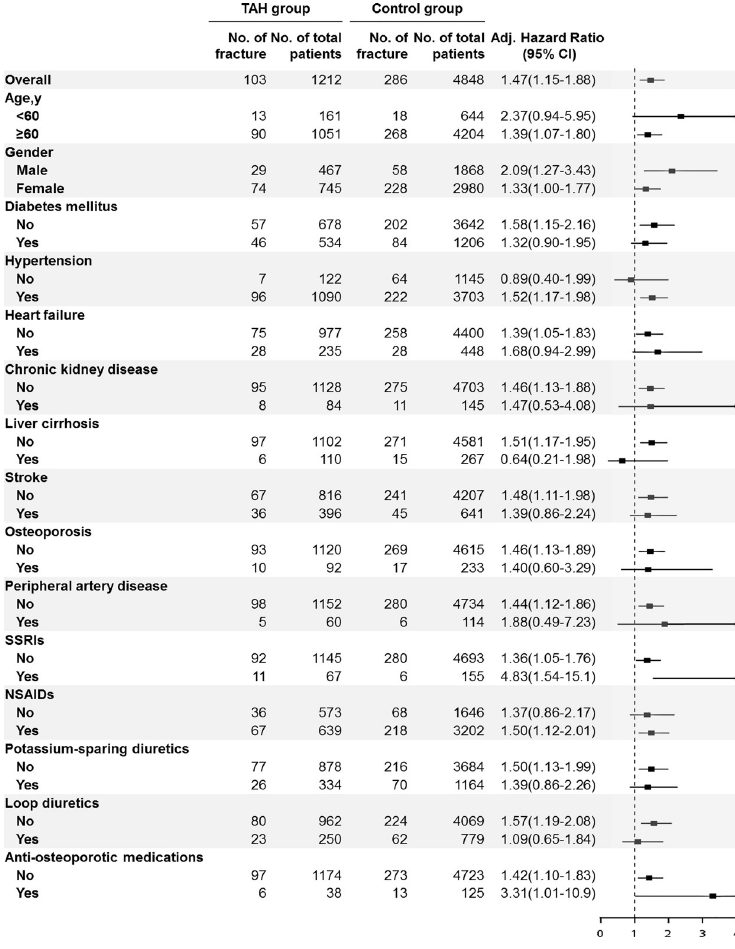
Fig 3. Subgroup analysis of association of thiazide-associated hyponatremia (TAH) with the risk of fracture.